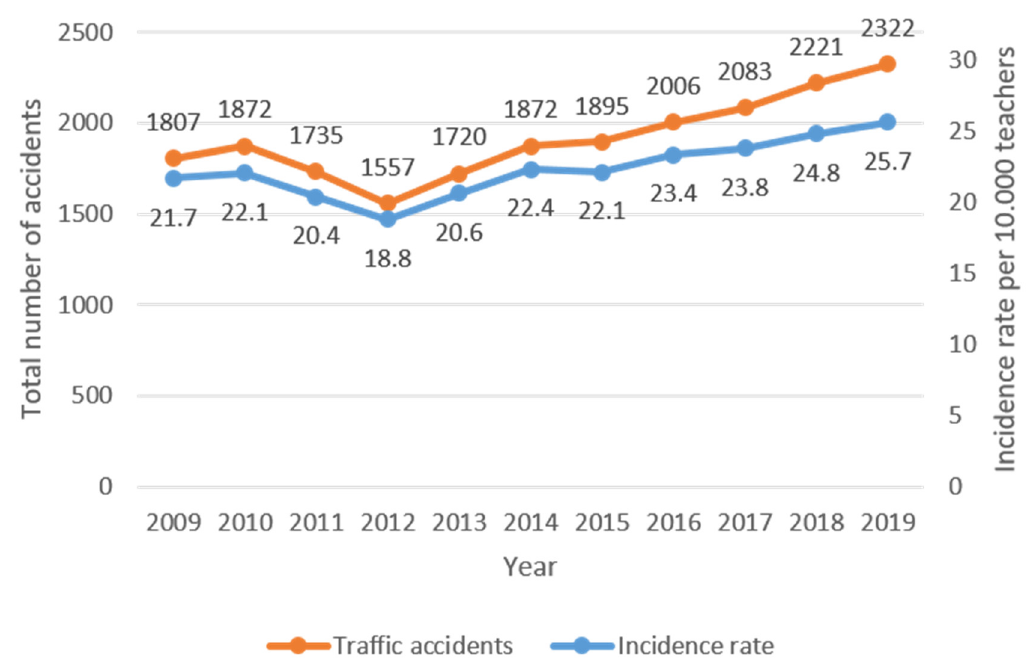
Figure 1. Traffic accidents and incident rates of teachers by year.